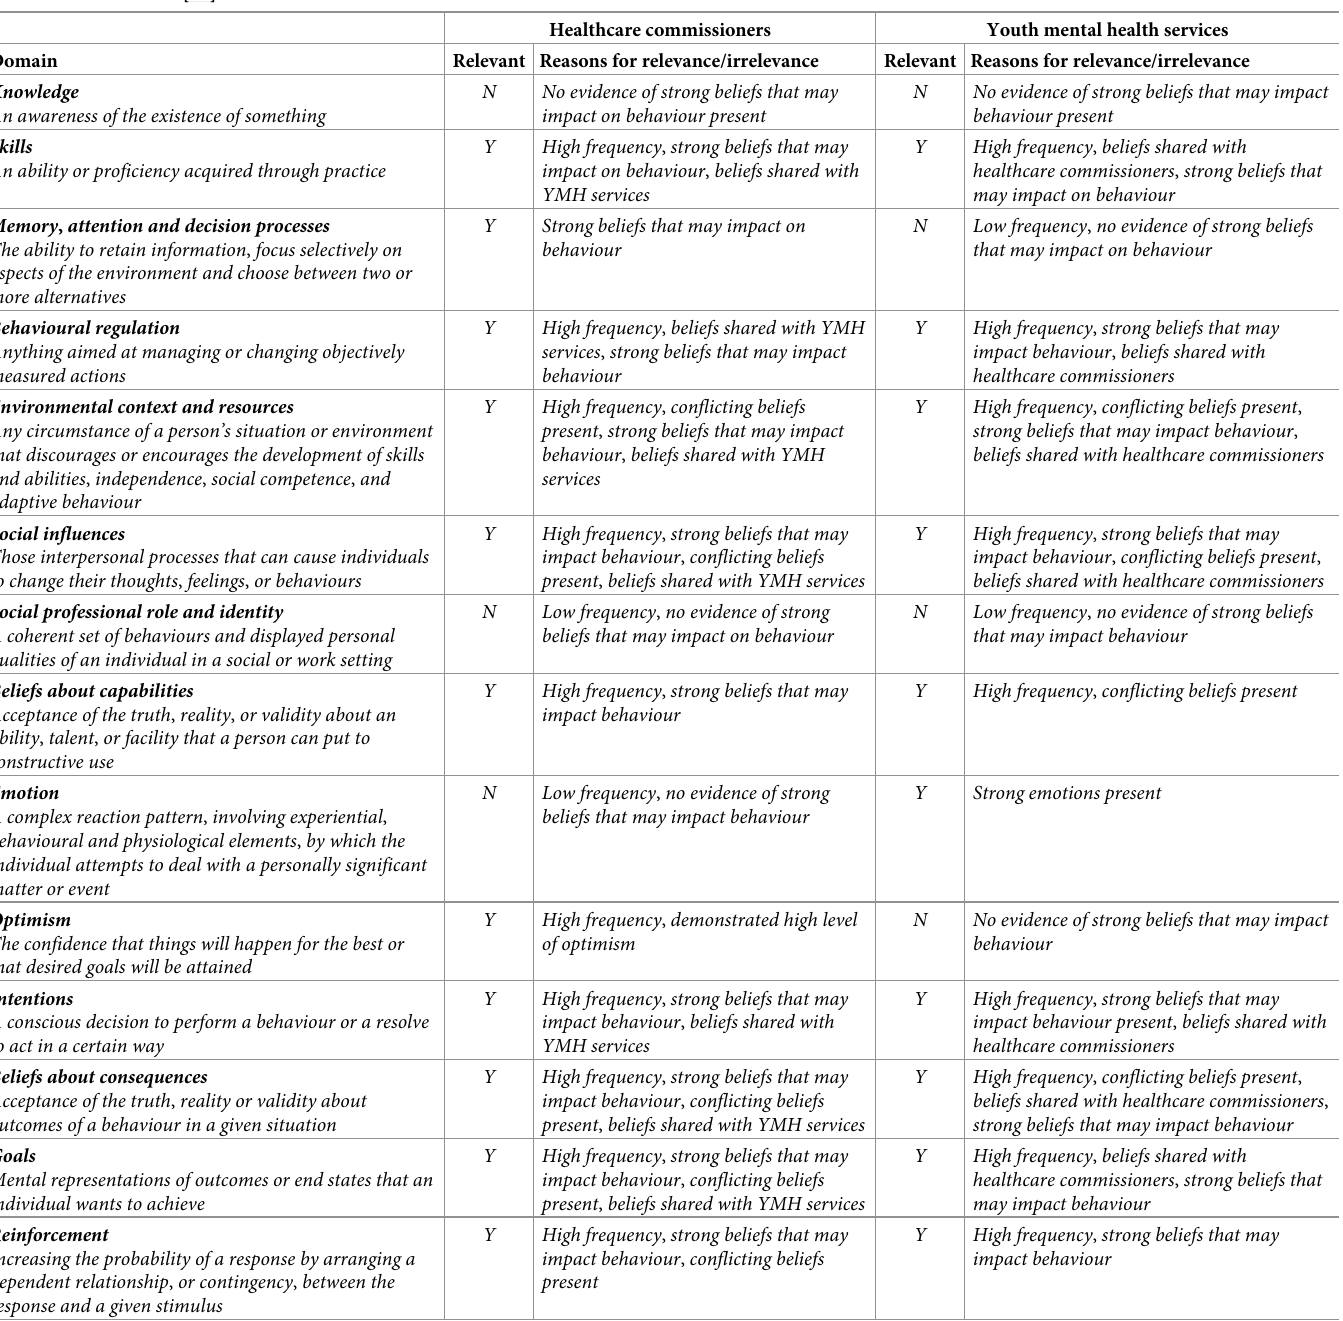
Table 3. TDF domains [32] and reasons for